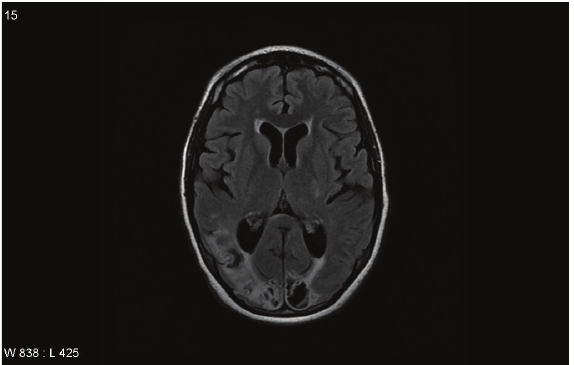
Figure 3: MRI brain 5 months after